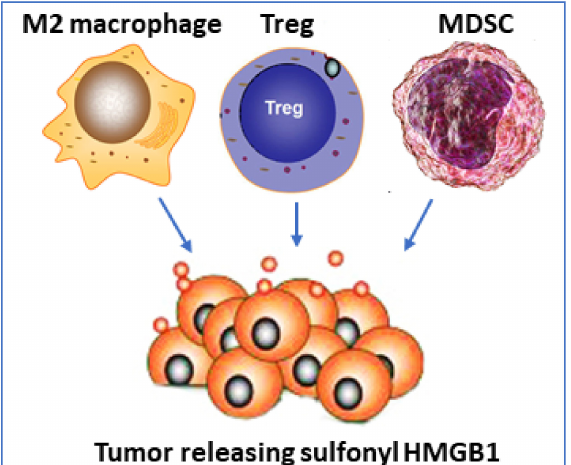
Figure 5. Fully oxidized HMGB1 inhibits cytotoxicity versus tumors. Tumor secreting sulfonyl HMGB1 which attracts M2 macrophages, regulatory T cells, and myeloid-derived suppressor cells (MDSC) which all inhibit a cytotoxic cell response against the